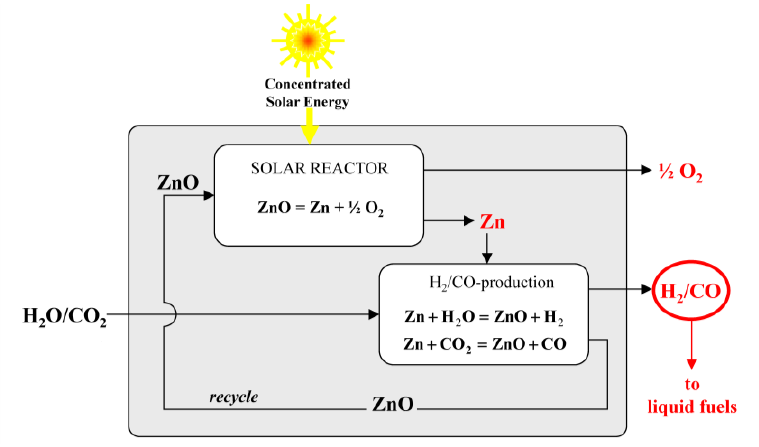
and/or CO from H O and/or CO 2 2 2